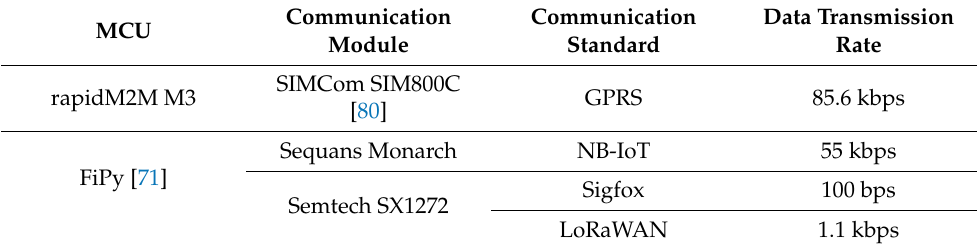
Table 3. Data transmission rates for the communication modules of the compared MCUs [71,80].